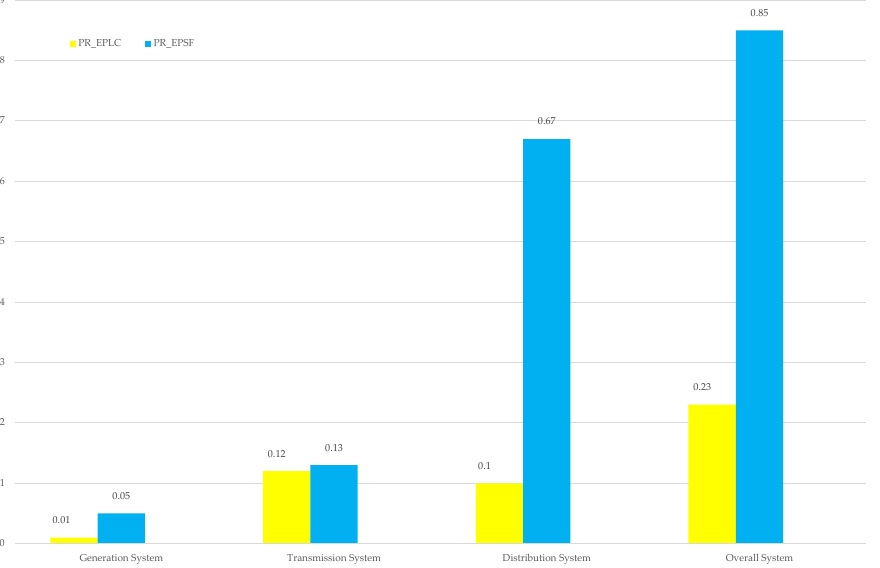
Figure 8. Comparison of subsystem count indicators.